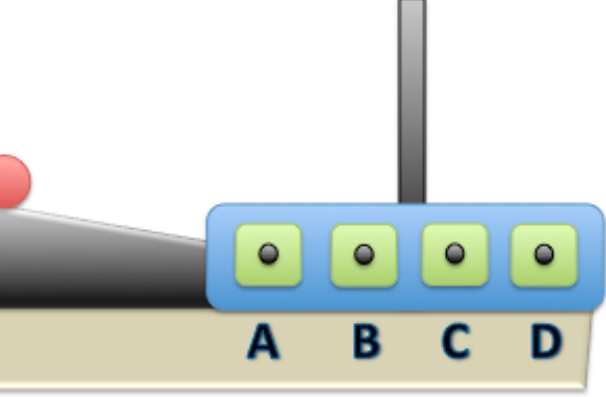
Figure 3. Older infants are commonly tested with this paradigm where a ball is rolled down the ramp and then children must search behind the correct door to find the ball. Though young infants seem to understand object solidity when tested in a looking paradigm, older infants often fail to search behind the correct door in the paradigm shown here. The cue of the barrier between door B and door C indicates that the ball should be found behind door B; however, infants may ignore this cue, may not have the ability to focus on the door and the cue simultaneously, may fail to execute the proper motor action, or may not be able to discriminate between the identical doors (Keen,